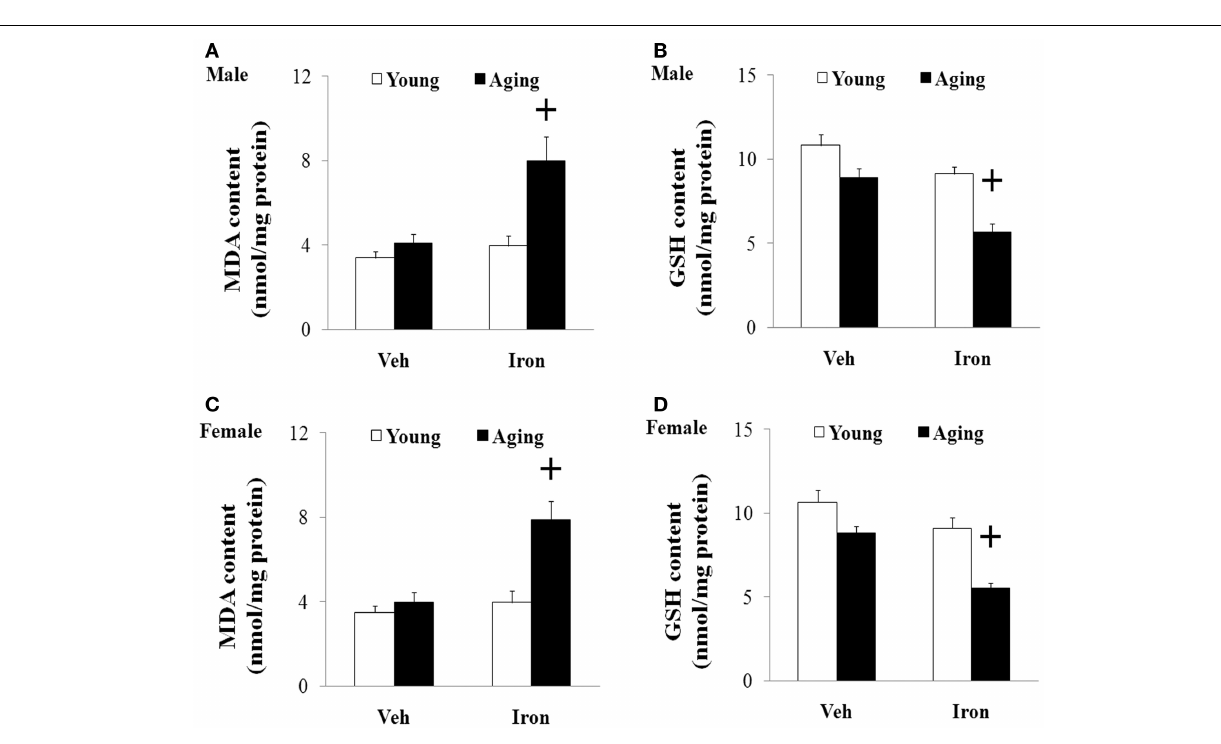
FIGURE 4 | Increased neonatal iron intake resulted in significant MDA (A,C) increase and GSH (B,D) decrease in the SN of male (A,B) and female (C,D) rats with aging . Results are expressed as mean ± SEM. N = 8–10. + p < 0.005, compared with the aging rats treated with Veh. MDA, malondialdehyde; GSH, glutathione; SN, substantia nigra; Veh,